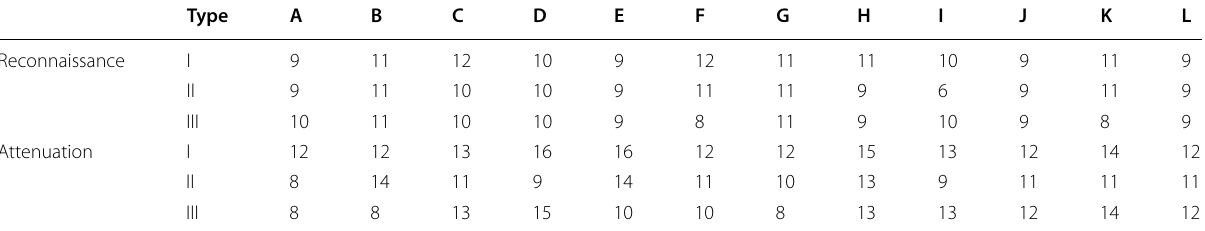
Table 14 Total scores of each type for the items that are checked during the reconnaissance and attenuation activities